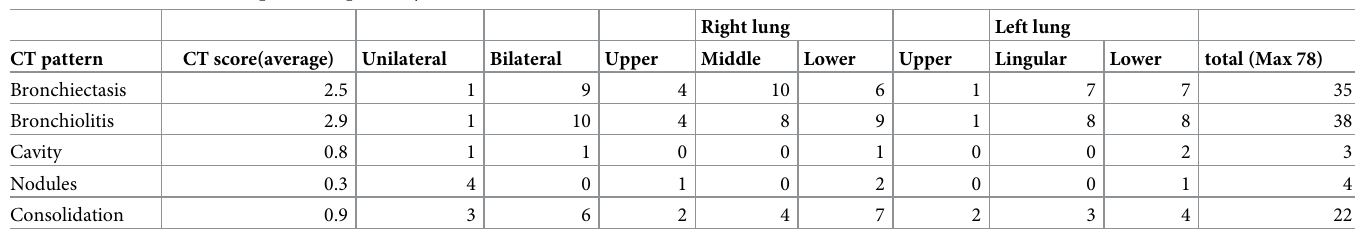
Table 3. Distribution and CT pattern of parenchymal abnormalities in Mab-PD (n = 13).